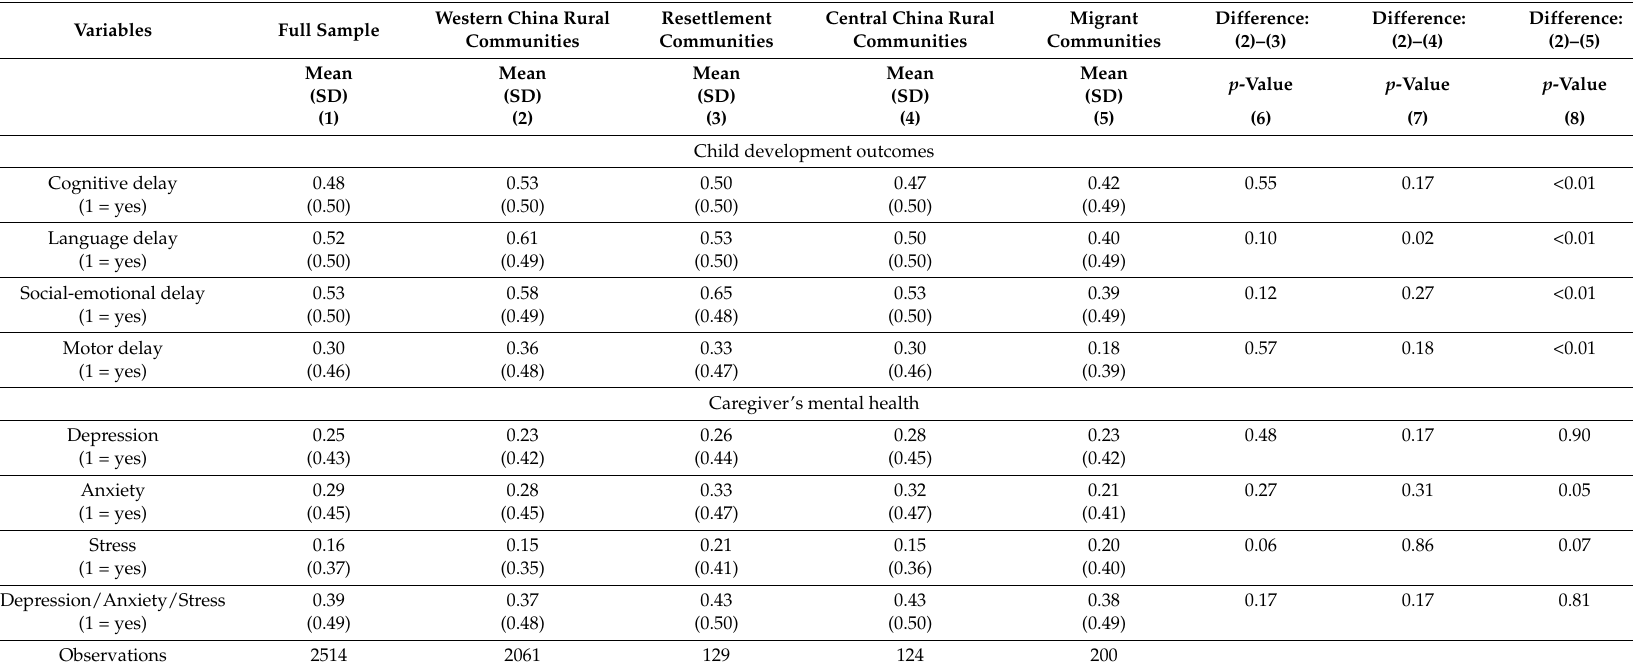
Table 3. Child development outcomes and caregiver’s mental health across different